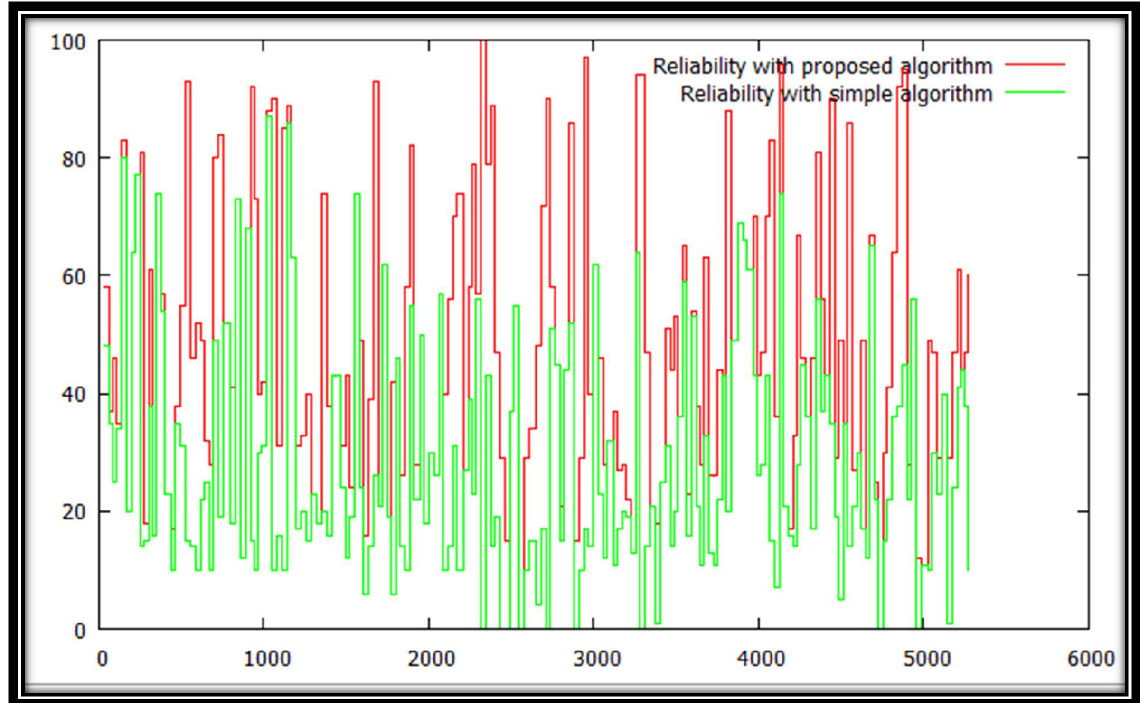
Fig. 12. Compared proposed method with previous